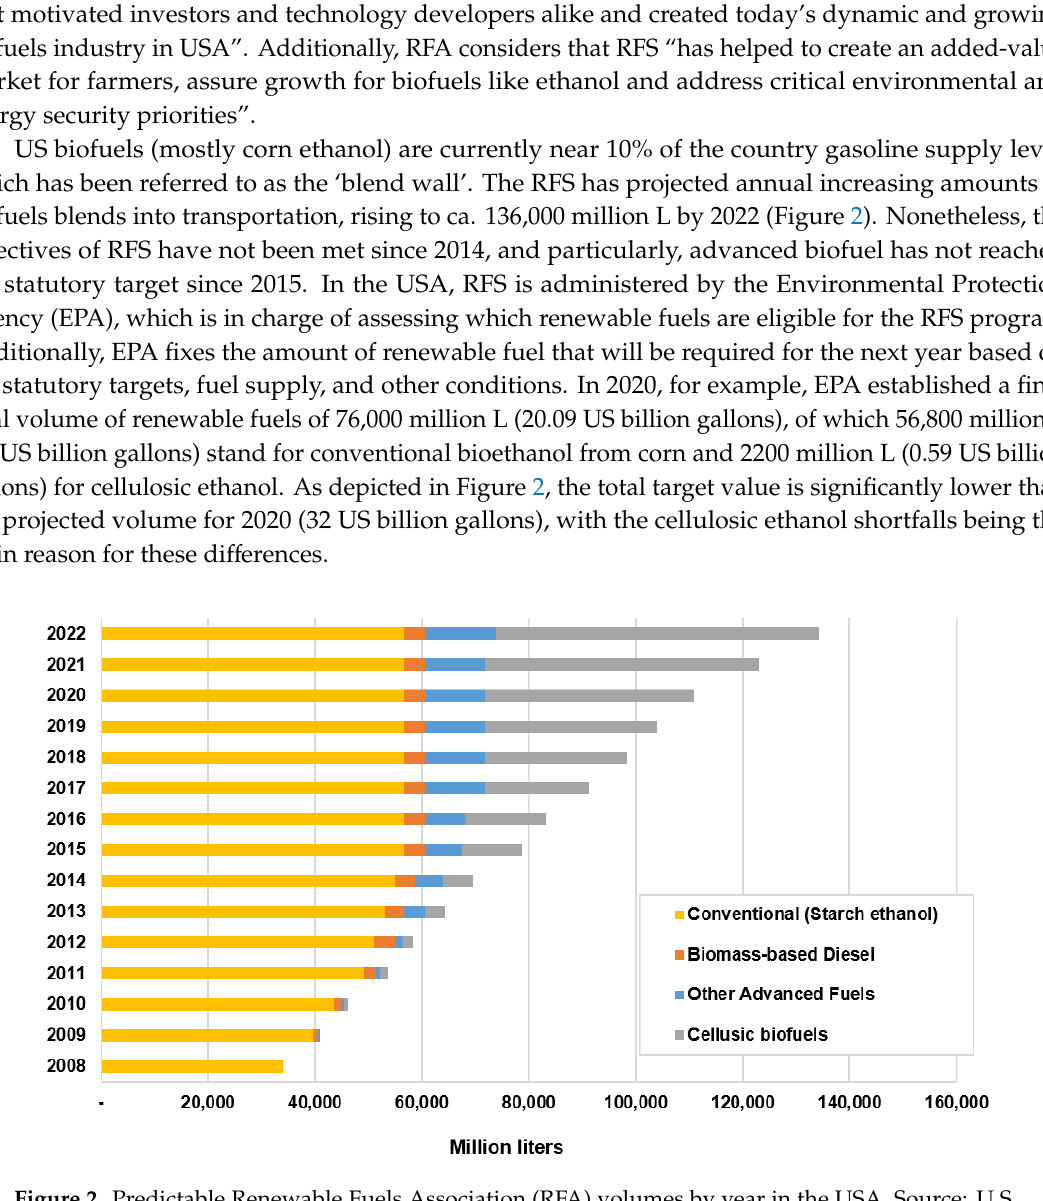
Figure 2. Predictable Renewable Fuels Association (RFA) volumes by year in the USA. Source: U.S. Department of Energy (https://afdc.energy.gov/laws/RFS.html)